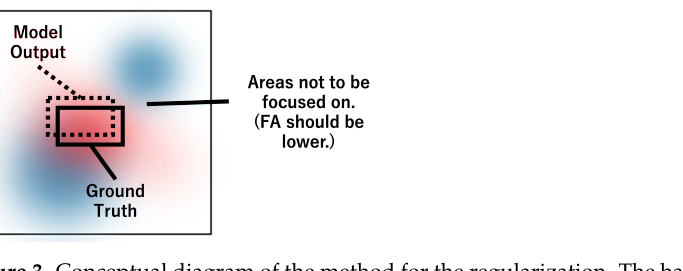
Figure 3. Conceptual diagram of the method for the regularization. The background image illustrates the saliency map of